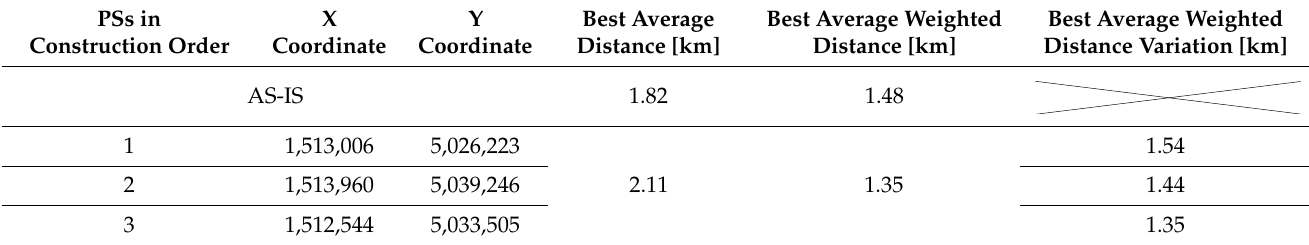
Table 4. Timing, siting of the new three PSs, and best average weighted distance values.